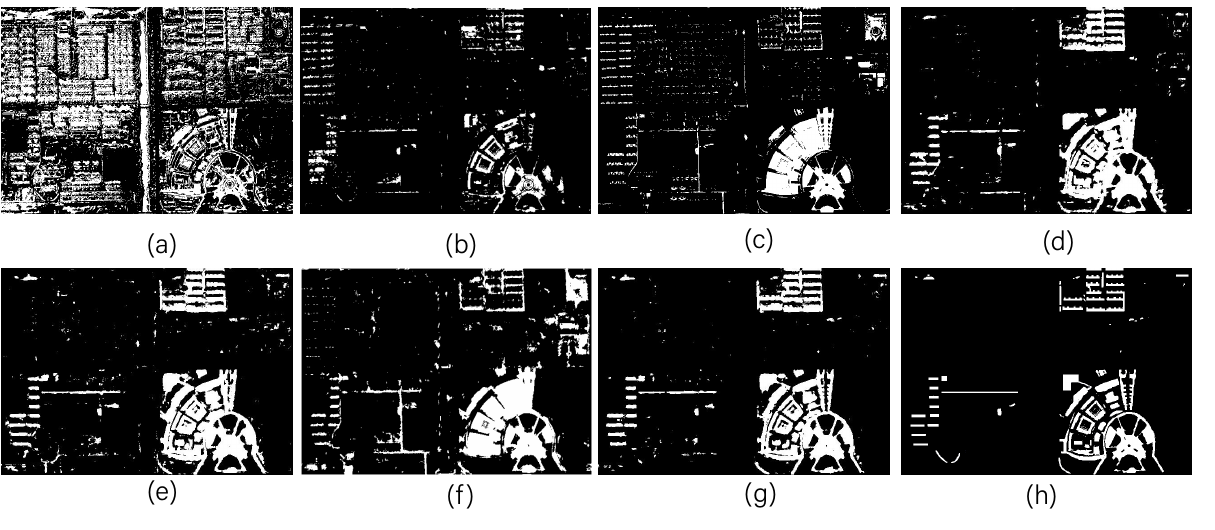
Figure 8. Binary change maps of Minfeng dataset. ( a ) CVA. ( b ) IRMAD. ( c ) SCCN. ( d ) SSJLN. ( e ) STA. ( f ) DSAMNet. ( g ) SJAN. ( h ) Ground truth. The unchanged samples are black and changed samples are white.